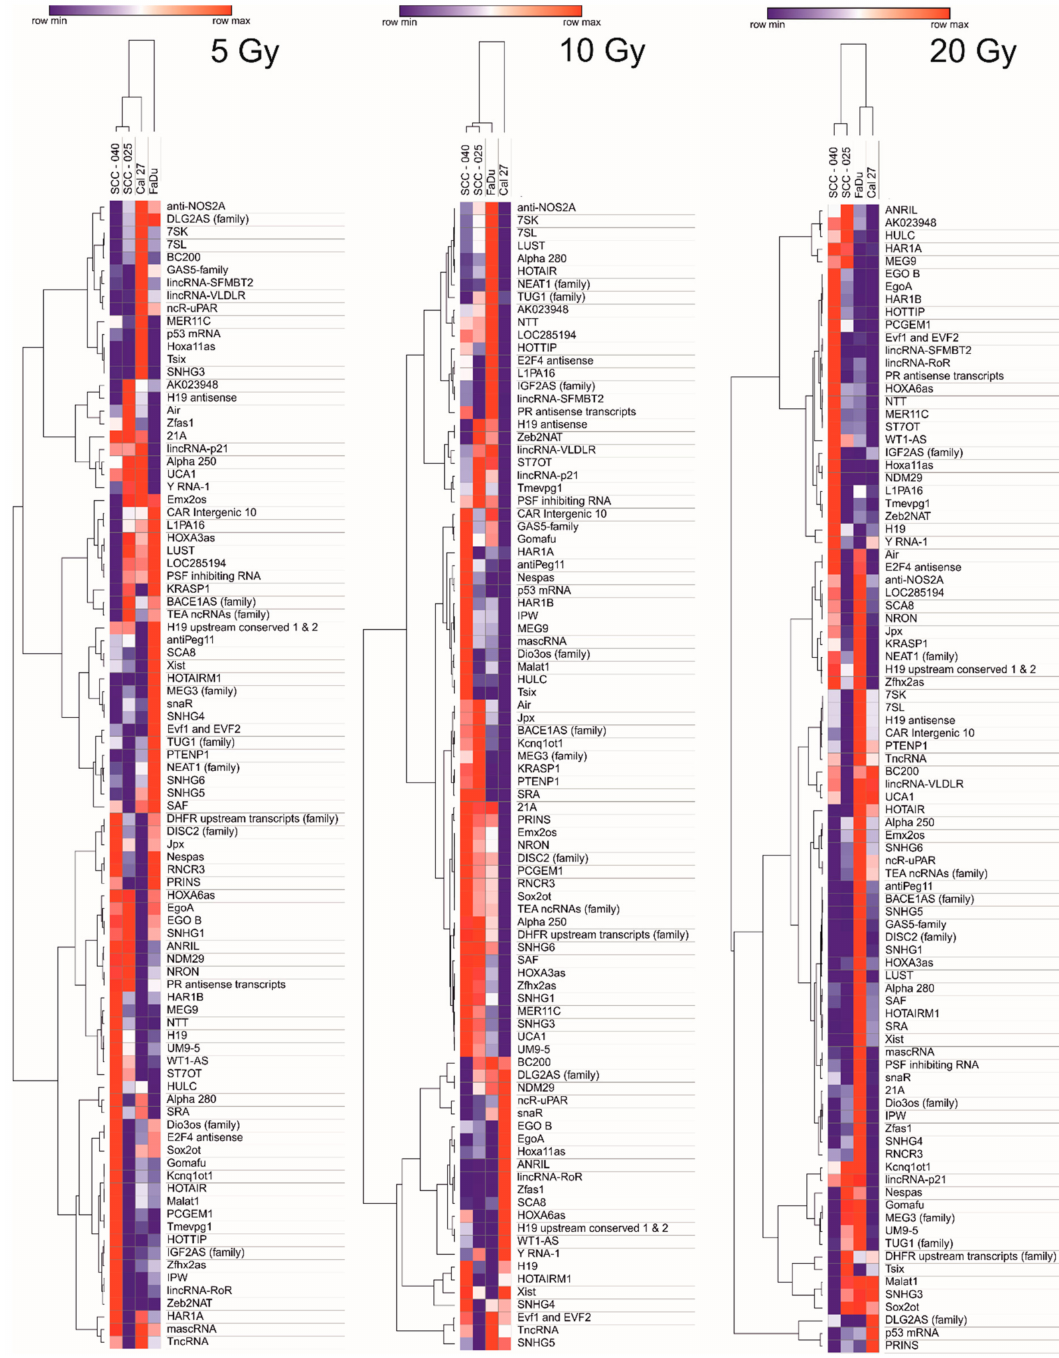
Figure 1. Heat map and clustering of 96 lncRNAs after irradiation of head and neck squamous cell carcinoma (HNSCC) cell lines using dose of 5 Gy, 10 Gy, and 20 Gy. Data shown as 2 − ∆∆ Ct (compared to non-irradiated